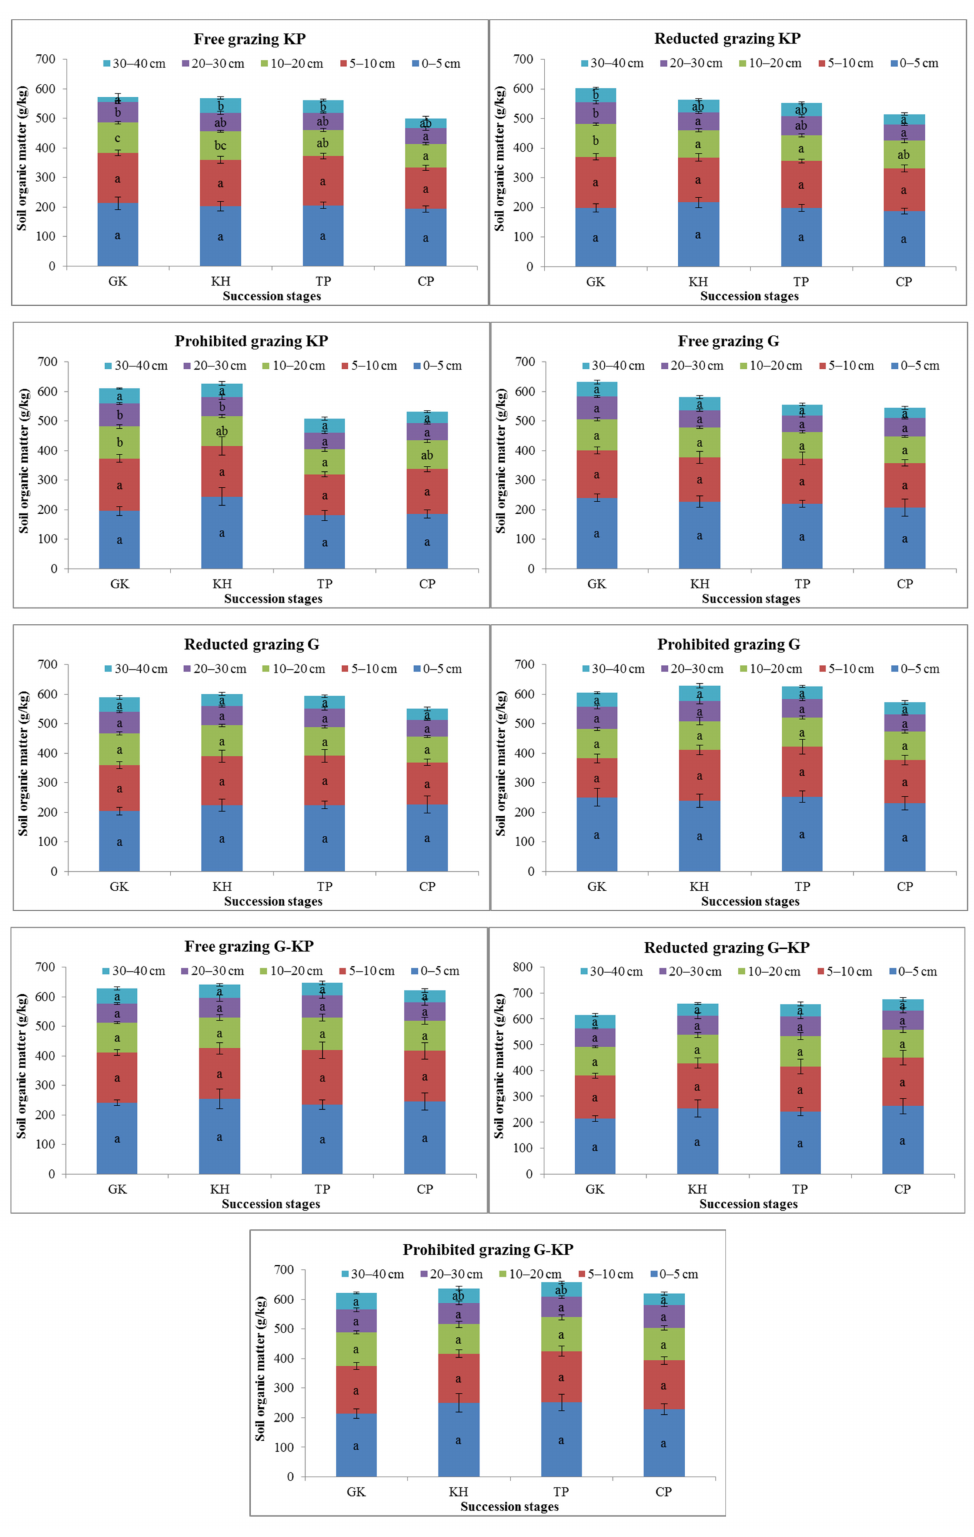
Figure 5. Variation in soil organic matter content in alpine Kobresia meadows. Notes: G, Gramineae micro-patches; G-KP, Gramineae transformation to K. pygmaea micro-patches; KP, K. pygmaea micro- patches; GH, Gramineae- K. humilis meadow; KH, K. humilis meadow; TP, K. pygmaea meadow with mattic epipedon thickening stages; CP, K. pygmaea meadow with mattic epipedon cracking stages. “a”, “b”, and “c” are the coefficients of significance for the different degradation